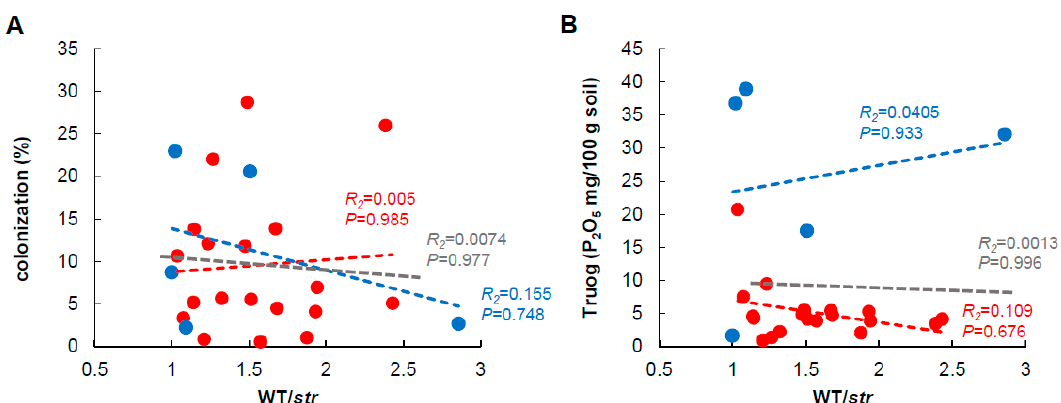
Figure 2. Indigenous mycorrhizal performance is not related to the early colonization potential of indigenous arbuscular mycorrhizal fungi and the soil phosphate levels. ( A ) The relationship between the performance of indigenous arbuscular mycorrhizal fungi (AMF) and the colonization potential of indigenous AMF in the soil. To evaluate the performance of indigenous AMF in the soils, we examined the growth ratios of wild-type and str mycorrhizal mutant using 24 soils. ( B ) The relationship between the performance of indigenous AMF and the level of phosphate (P) in the soil (Truog-P). Red- and blue-dotted lines are the regression lines calculated from the values of non-cultivated soils and cultivated soils, respectively. Gray-dotted lines are the regression lines calculated from all data.